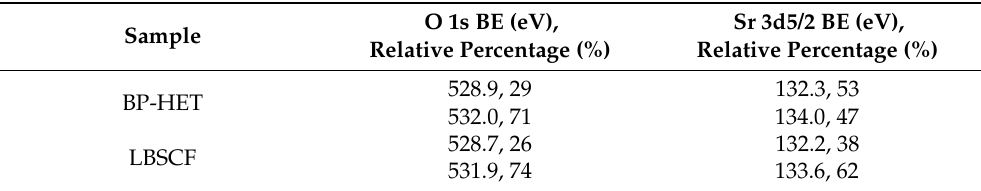
Figure 4. High resolution XPS O1s ( a ) and Sr 3d ( b ) region, respectively. Experimental signals (black lines), fitted model (red line), deconvolution O signal (light-blue and purple areas) and deconvolution Sr signal (green and yellow areas). Table 2. XPS data of BP-HET and LBSCF in terms of O 1s and Sr 3d5/2 binding energies and the relative percentage of the different component are